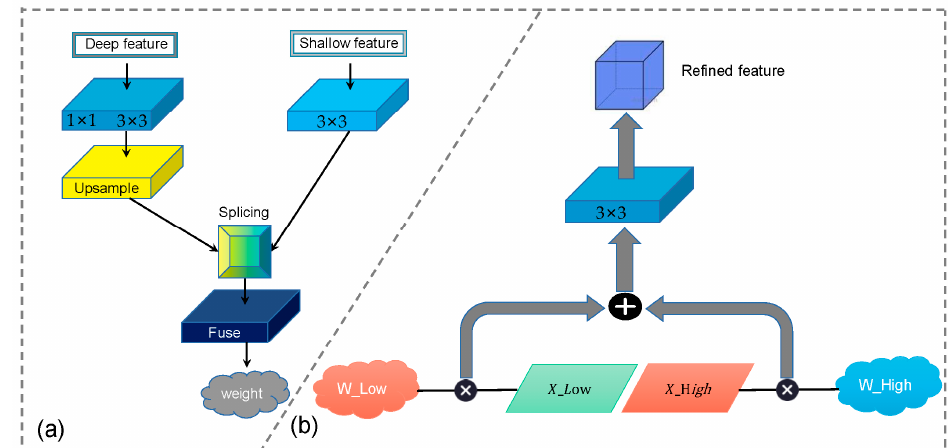
Figure 6. AFM architecture diagram. The Adaptive Fuse Module consists of two parts. The left part ( a ) is the process of obtaining the weights of deep feature maps and shallow feature maps, aiming to achieve the filtering effect of deep features on shallow noise. The right part ( b ) is a schematic diagram of the operating mechanism of the Adaptive Fuse Module.